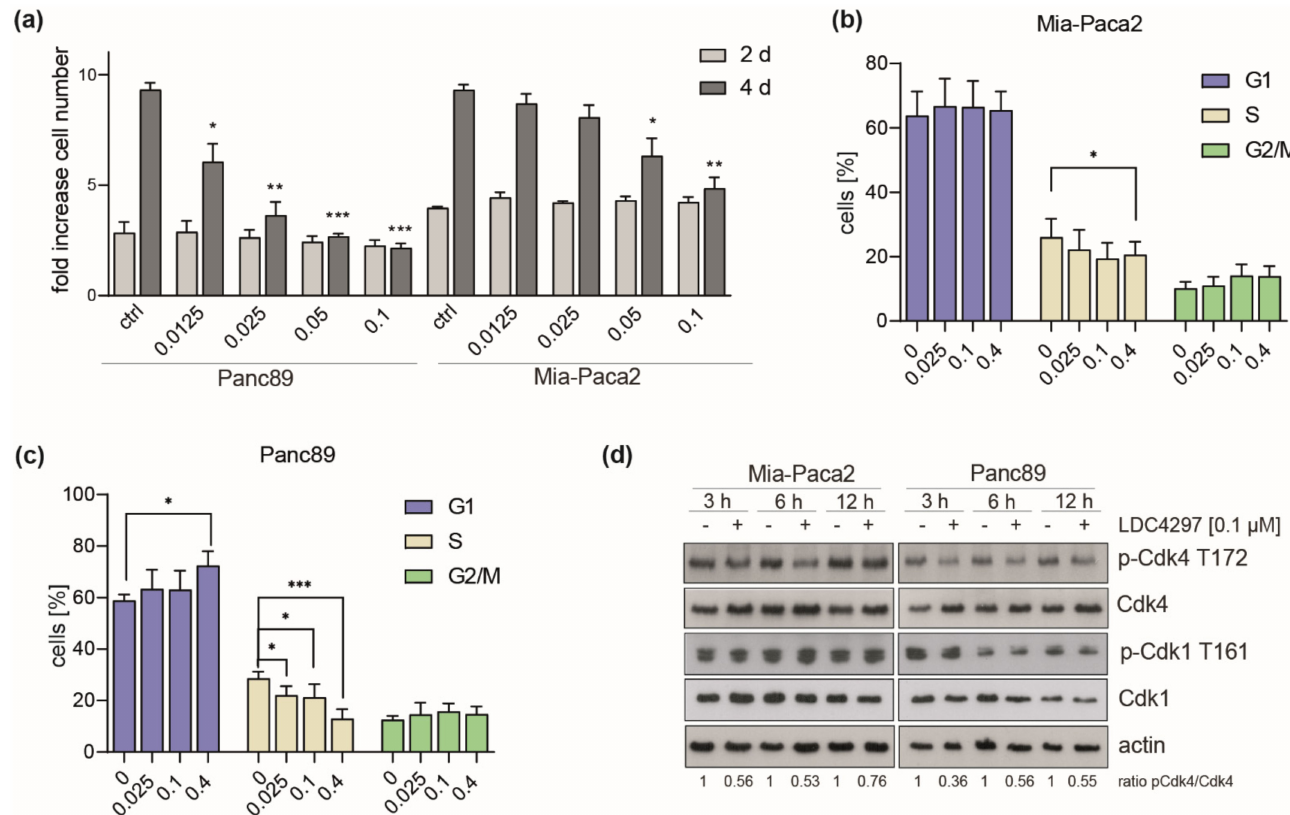
Figure 2. Differential alterations in cell cycle distribution following CDK7 inhibition. ( a ) Mia- Paca2 and Panc89 cells were treated with the indicated concentrations of LDC4297 [ µ M] for 2 and 4 days and viability was analyzed. Shown are the mean ± SD ( n = 3). ( b , c ) Mia-Paca2 ( b ) and Panc89 ( c ) cells were treated with the indicated LDC4297 concentrations [ µ M] for 4 days and cell cycle states analyzed by FACS. Shown are the mean ± SD ( n = 5). ( d ) Immunoblot analysis of Mia-Paca2 and Panc89 lines treated with 0.1 µ M LDC4297 for 3, 6 or 12 h. Intensities of bands were analyzed by Image Studio Lite software (Licor). Significance was analyzed by two-sided Student’s t -test: * p ≤ 0.05; ** p ≤ 0.01; *** p ≤